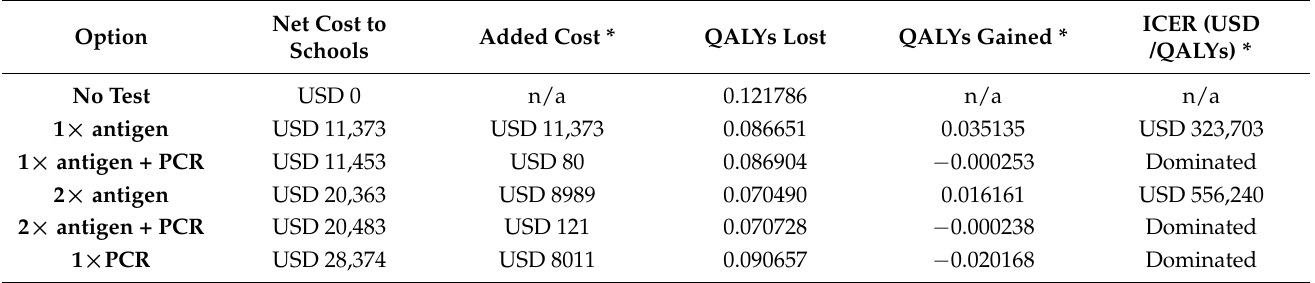
Table 3. Cost-effectiveness of testing strategies from the school perspective, per thousand tested.